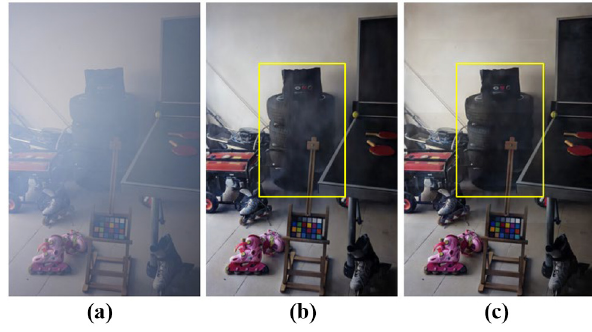
Figure 5. Image dehazing with L2 loss and edge- preserving